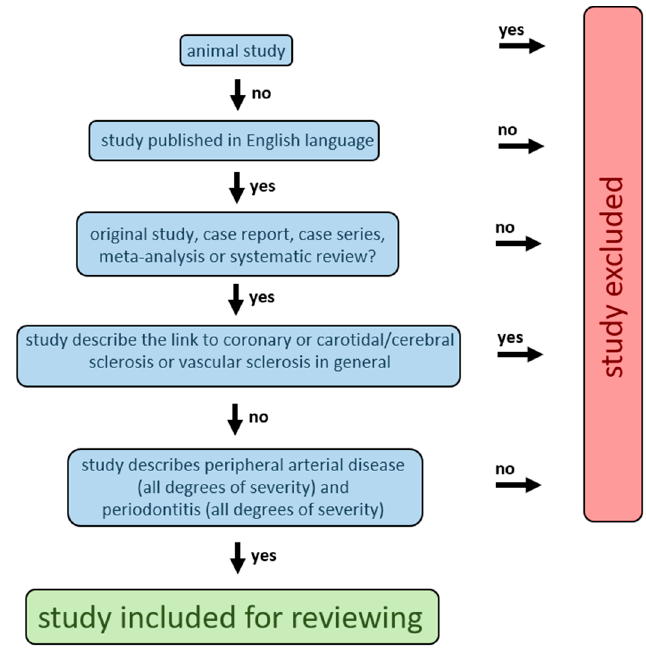
Figure 3. Screening algorithm.